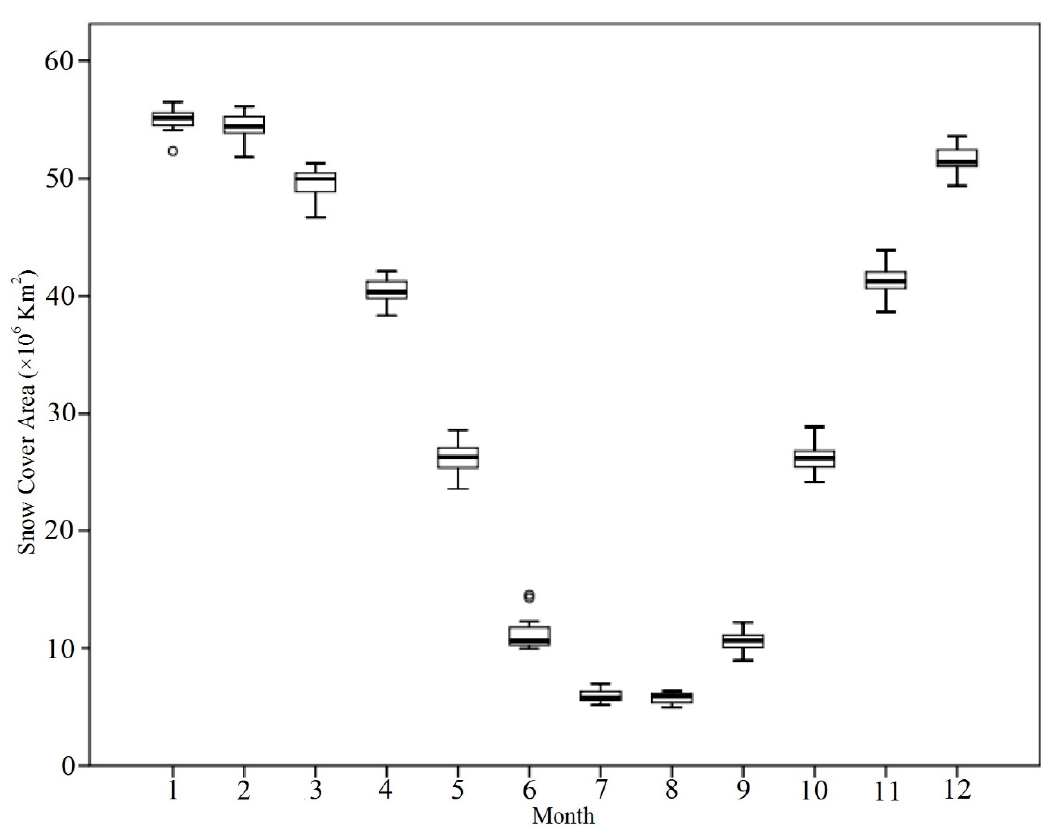
Figure 5. Box plots of the monthly averages of snow-covered areas between 2000 and 2015.